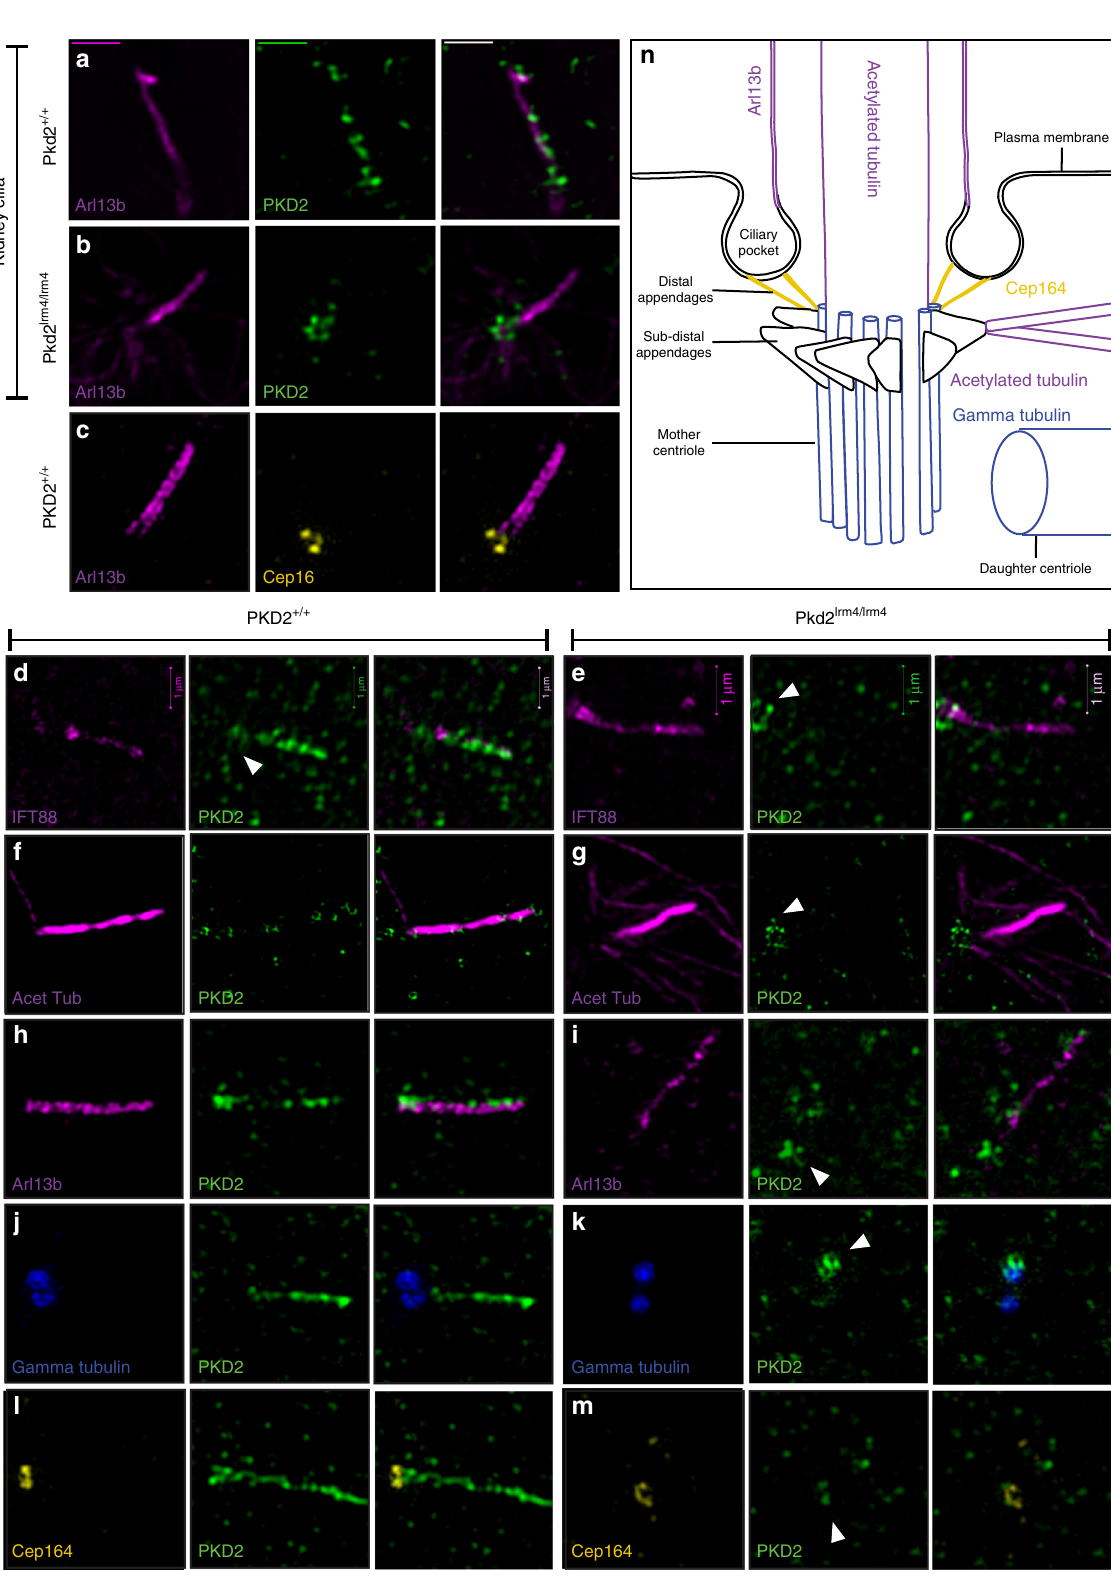
(Fig. 5g). Rather than being reduced in Pkd2 lrm4/lrm4 cells,